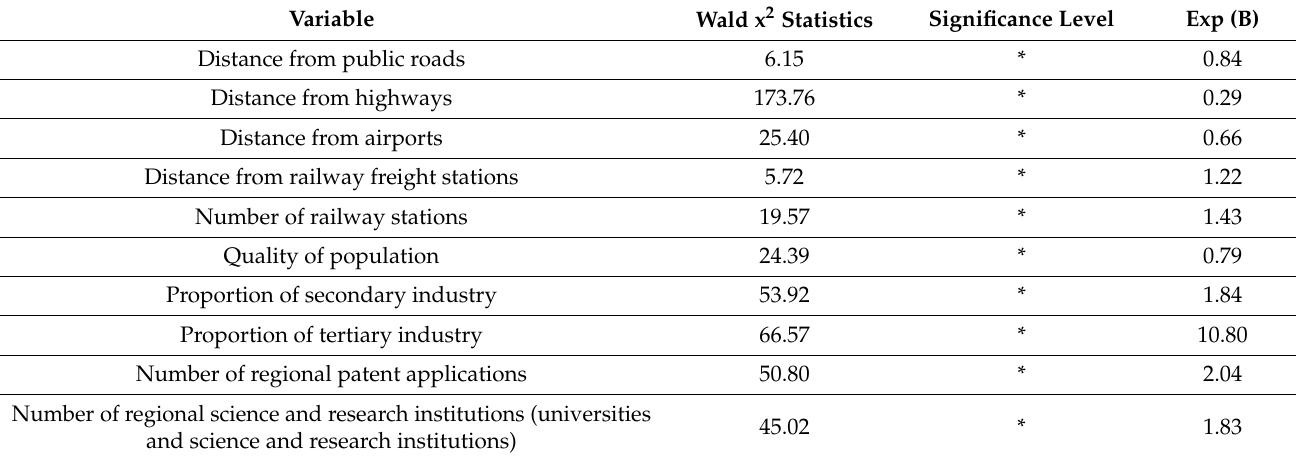
Table 3. Model estimation results of industrial land use in